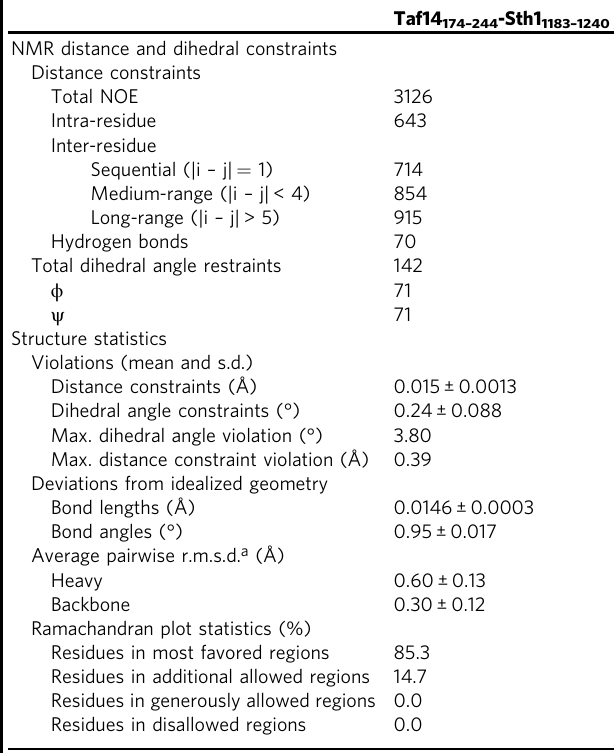
Table 1 NMR and re fi nement statistics for the Taf14 174 – 244 - Sth1 1183 – 1240 structure.